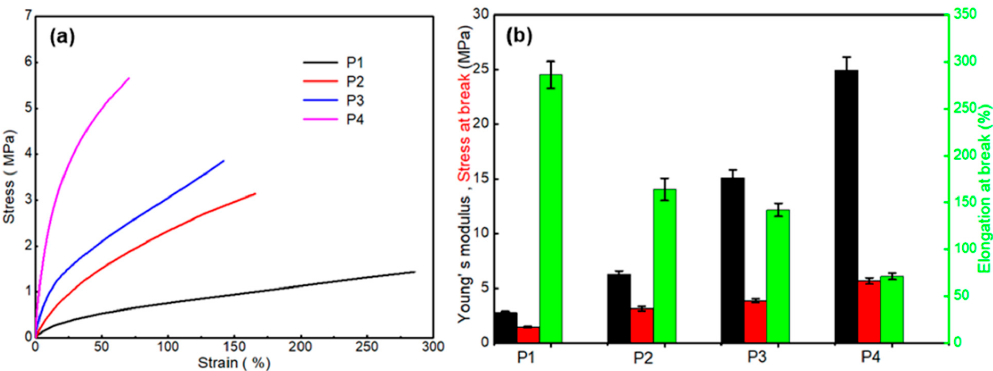
Figure 5. Stress-strain curves for the films, (a) DMA curves of these films (b) Young's Modulus, stress at Break, and tensile strength of these cured samples.